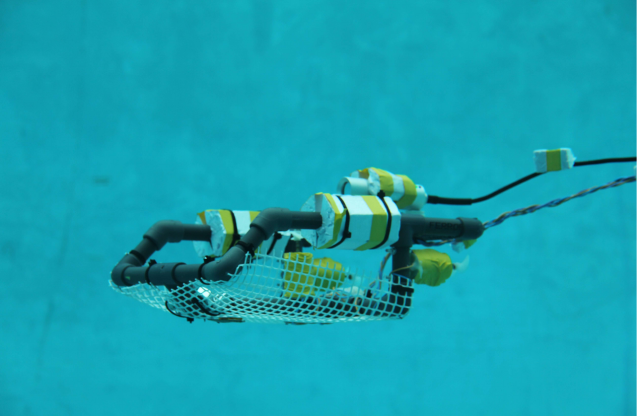
Figure 2. Example of vehicle built at the workshop.